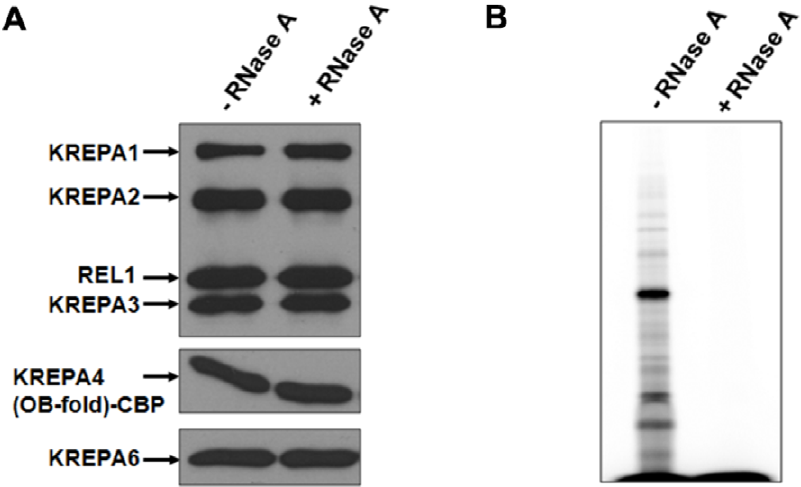
Figure 6. The association of KREPA4 with editing complexes is not mediated via RNA interactions. (A) The TEV eluate from KREPA4 (OB- fold) TAP-tagged cells was either treated with RNase A or left untreated, followed by calmodulin affinity purification and western analysis of eluates with antibodies as indicated. (B) pCp labelled RNA extracted from the calmodulin eluates of RNase treated and untreated samples as indicated, to monitor RNase